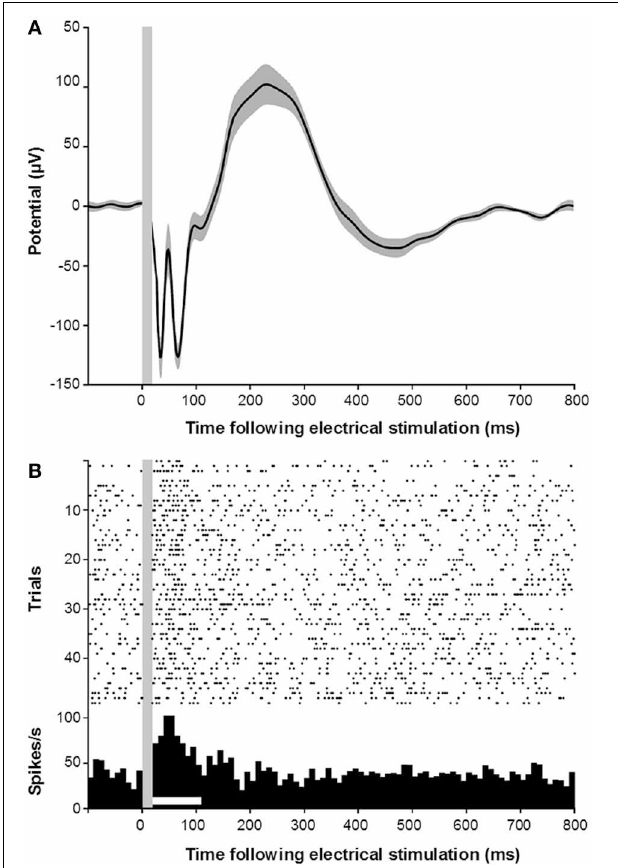
FIGURE 5 | (A) Electrically evoked potential recorded in the auditory cortex following electrical stimulation of the red nucleus. Gray shading indicates s.e.m. Gray vertical bar indicates the stimulus artifact. (B) Electrically evoked multiunit responses in the auditory cortex following electrical stimulation of the red